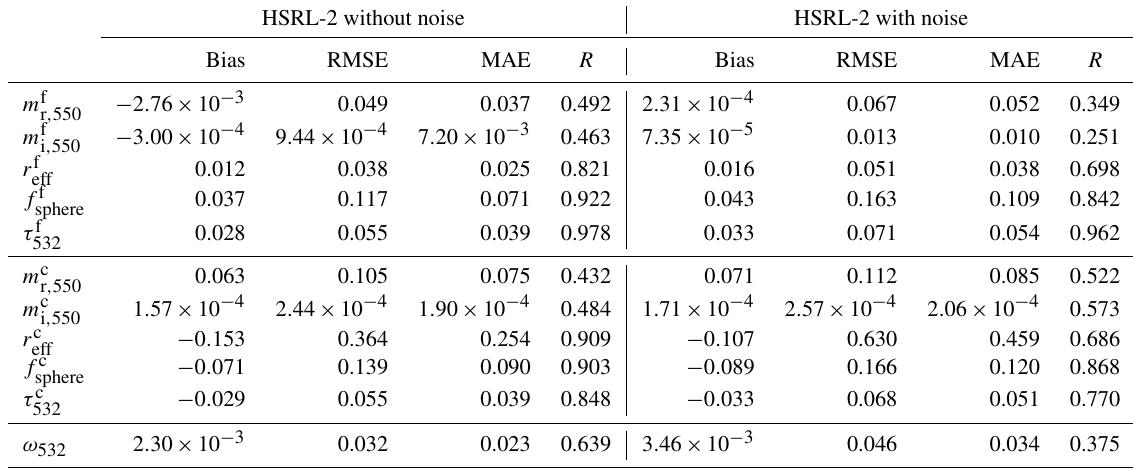
Table 3. Results for retrievals with the 2 α + 3 β + 3 δ pol HSRL-2 configuration with and without noise.